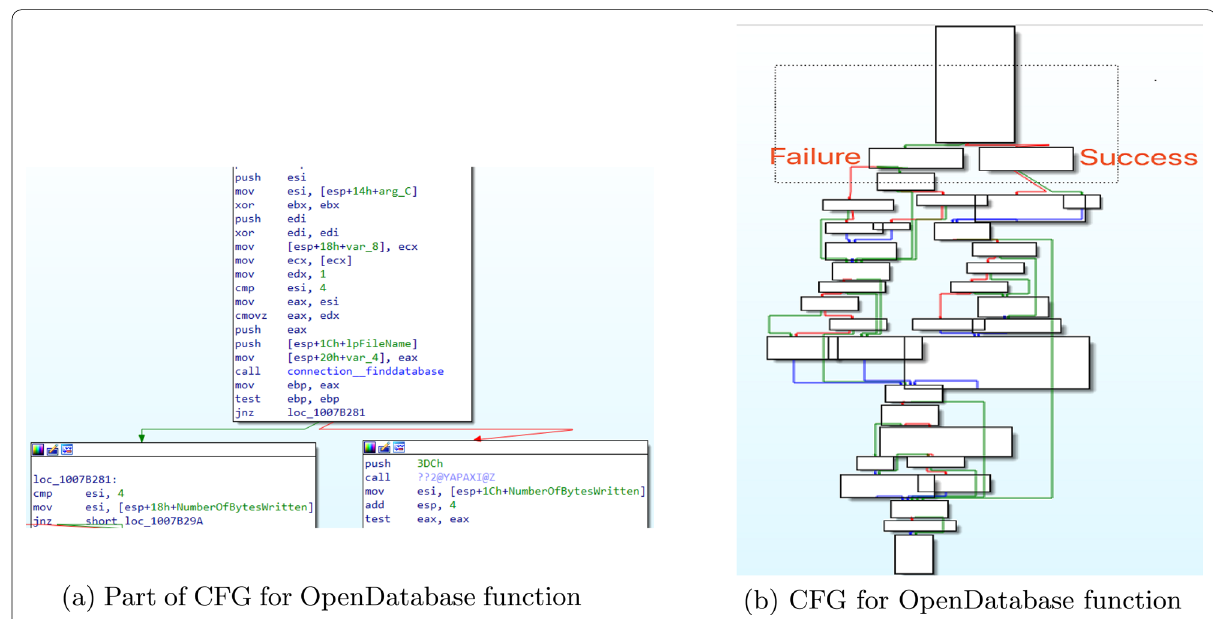
Fig. 6 OpenDatabase